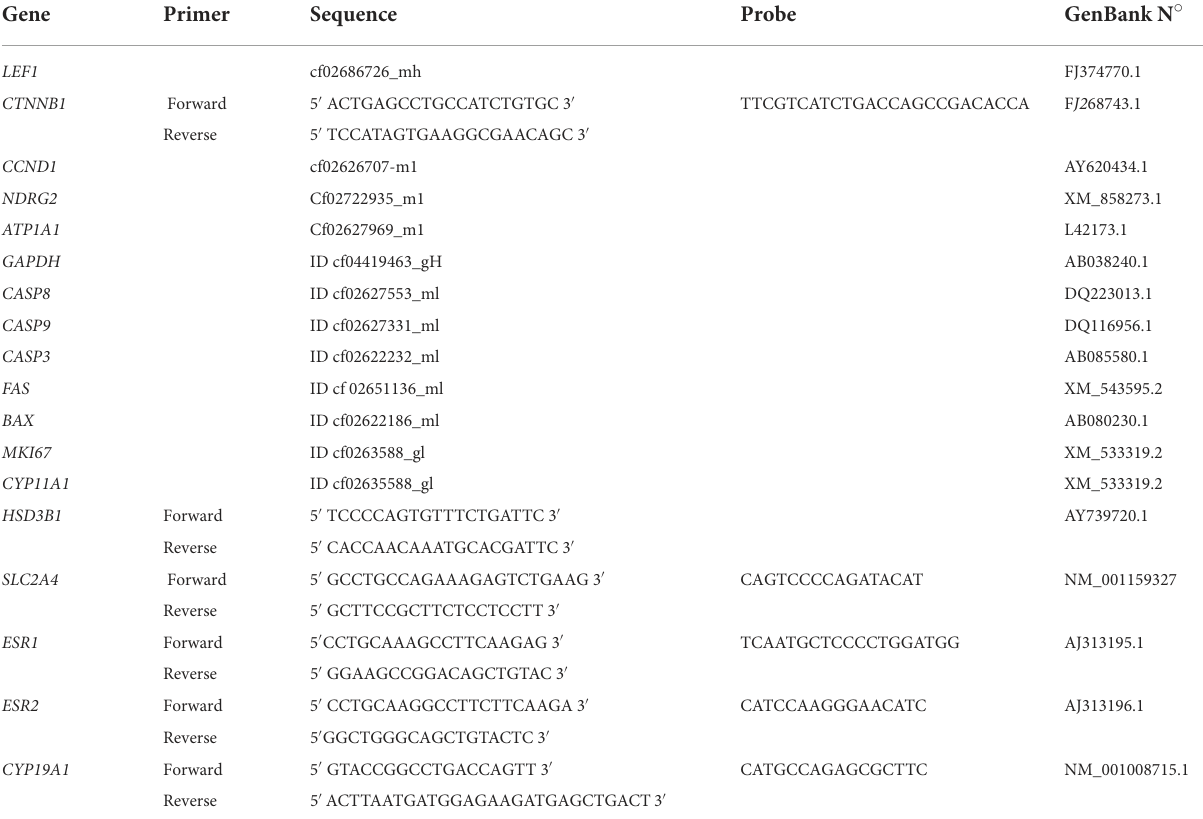
TABLE 1 List of qRT-PCR